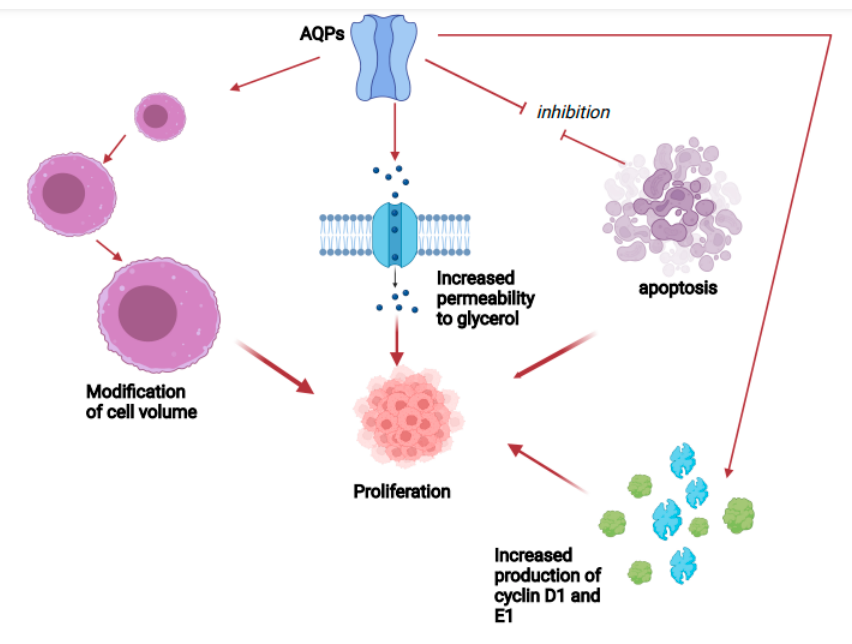
Figure 2. Effects of AQPs on cell